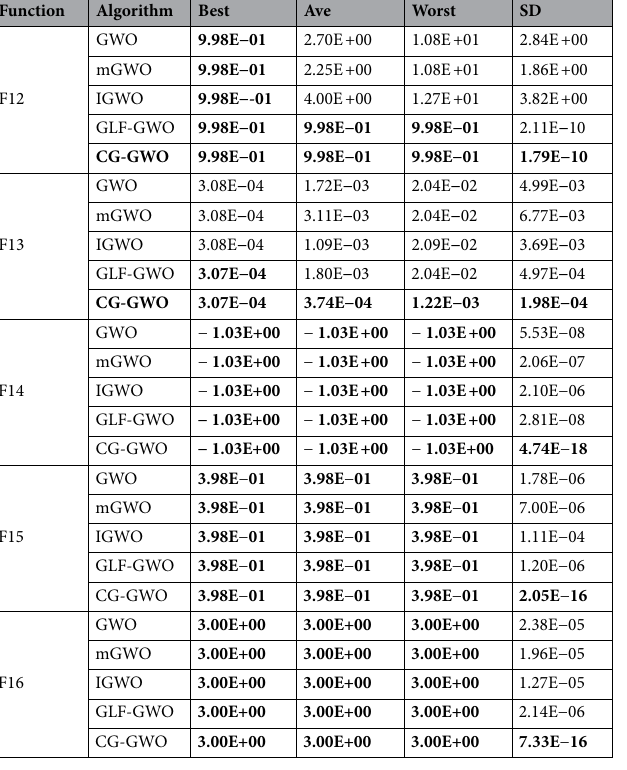
Table 6. Experimental results comparison of improved GWO